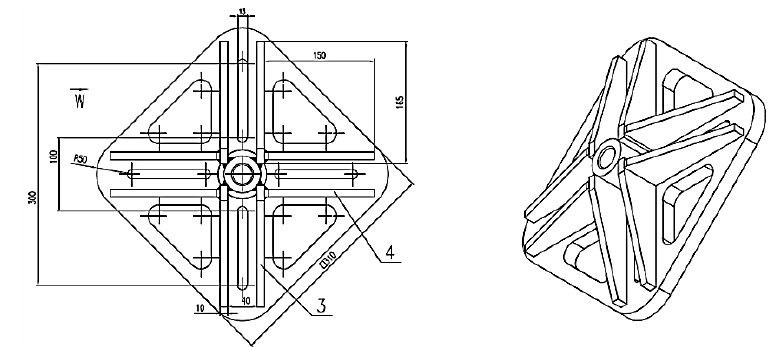
Figure 8. The schematics of the fastening plane for a system of two (four) anchors.